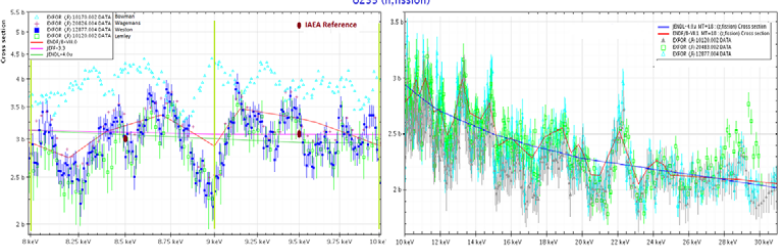
Fig. 1. 235 U(n,f) experimental data from EXFOR. The ENDF/B-VIII. JENDL-3.2 and the IAEA evaluations are also